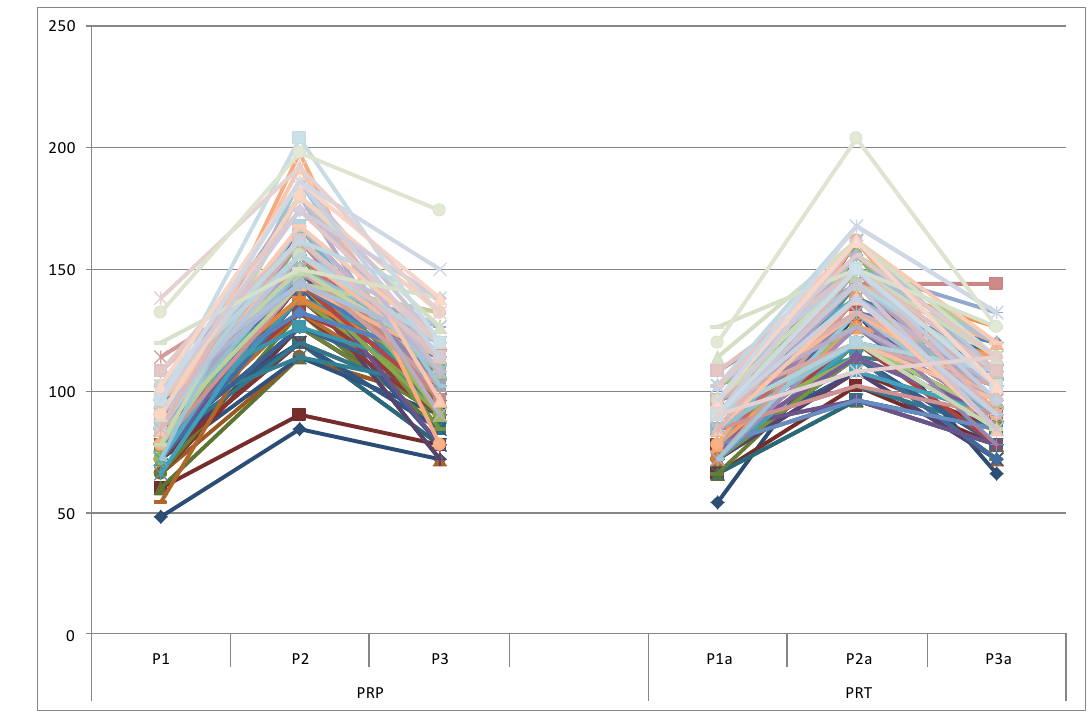
Fig.1. Results of heart beats rate registration (HBR) in Ruffier’s test with squatting and torso rising from lying on back position: PRP – Ruffier’s test with squatting; PRT - Ruffier’s test with torso rising; P1, P2, P3 – HBR values in Ruffier’s test; P1a, P2a, P3a – HBR in adapted Ruffier’s test.